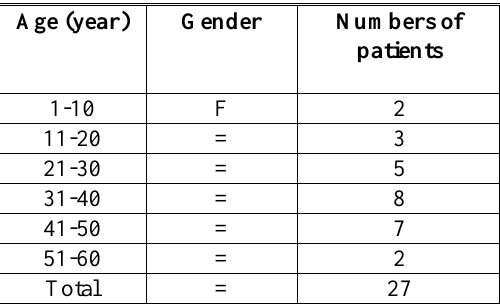
Table (2) Age distribution of anti H.pylori